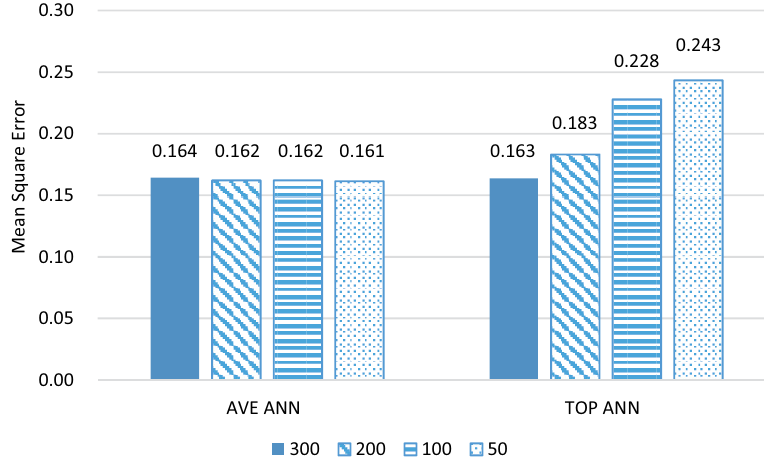
Figure 8. Mean Square Error for the average of all the net results and the best net for different committee